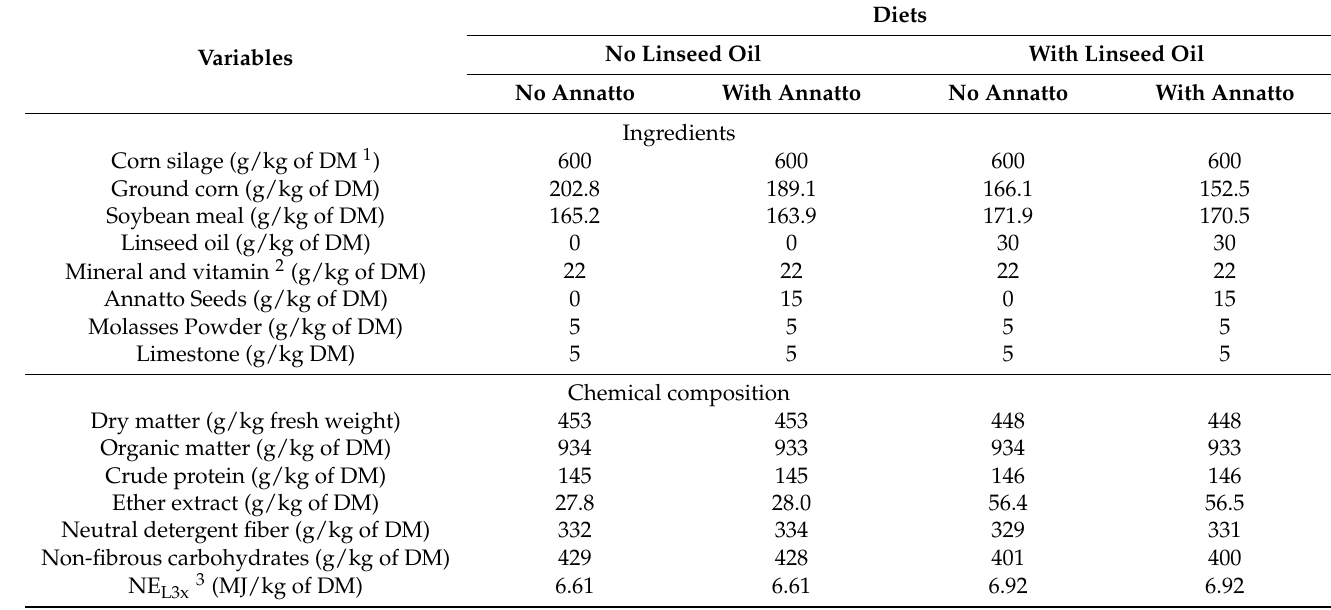
Table 1. Ingredients and chemical composition of total mixed diets.